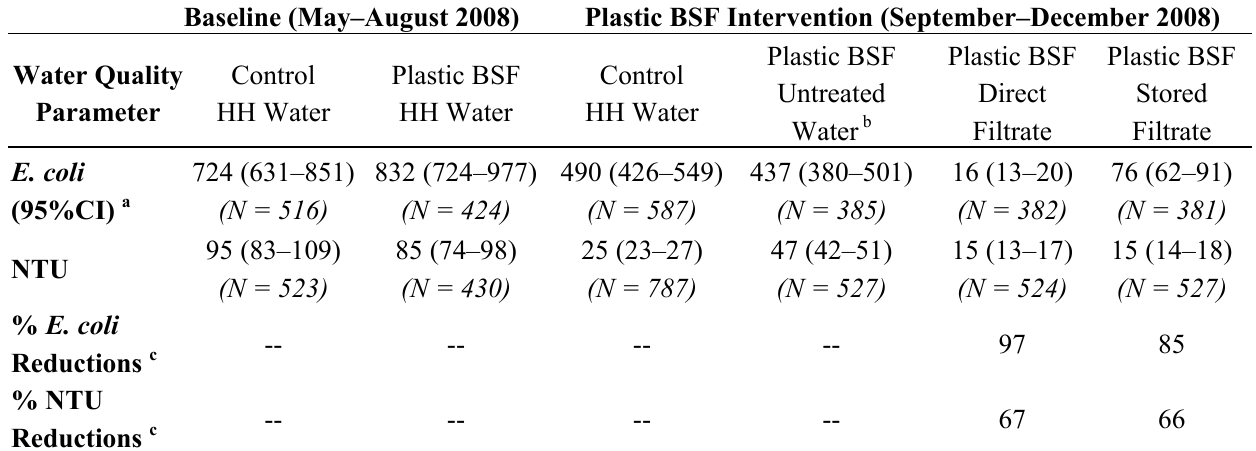
Table 4. Geometric mean E. coli concentrations and turbidities of household drinking waters for the control and plastic BSF groups before and after plastic BSF intervention in a randomized control trial in rural Tamale, Ghana